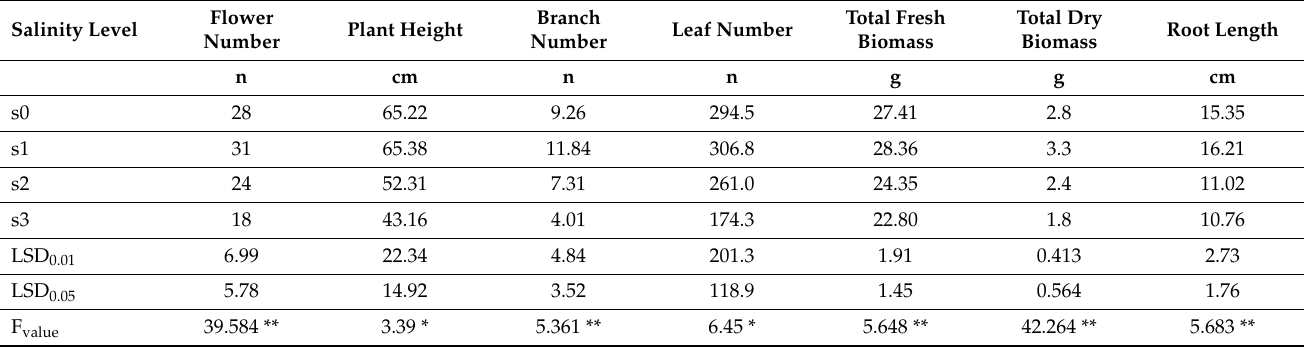
Table 3. Effect of salinity stress treatment on periwinkle flower number (n), plant height (cm), branch number (n), leaf number (n), total fresh biomass (g/plant), total dry biomass (g/plant), and root length